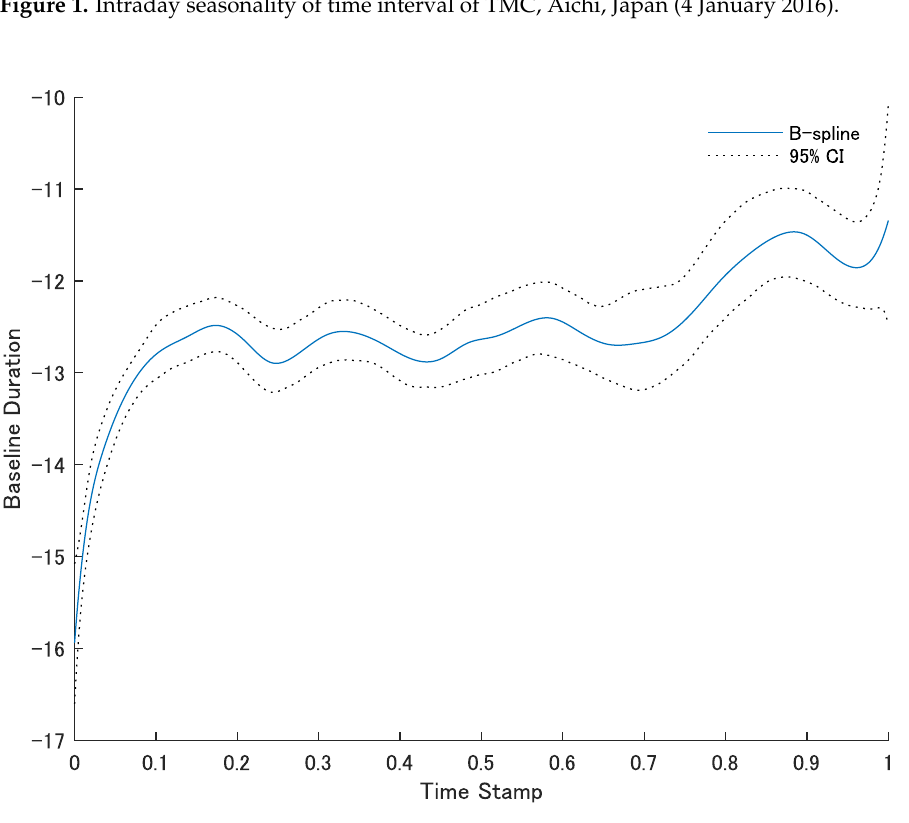
Figure 1. Intraday seasonality of time interval of TMC, Aichi, Japan (4 January 2016).